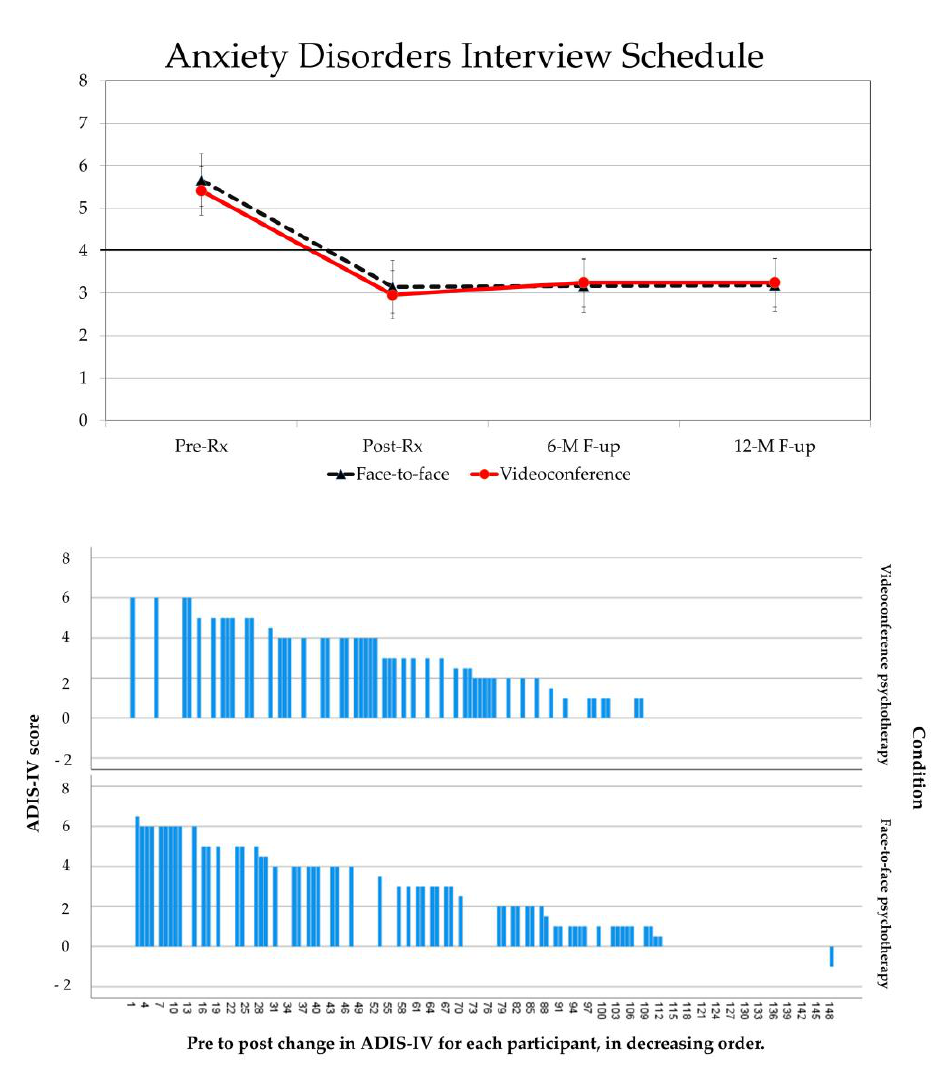
Figure 2. Visual representations of the results on the ADIS-IV primary outcome measure for 148 adults diagnosed with GAD who received cognitive-behavior therapy in videoconference (VCP) or face-to- face, with data aggregated by condition (line-graph, top) and pre to post change data reported for each individual (waterfall bar chart,